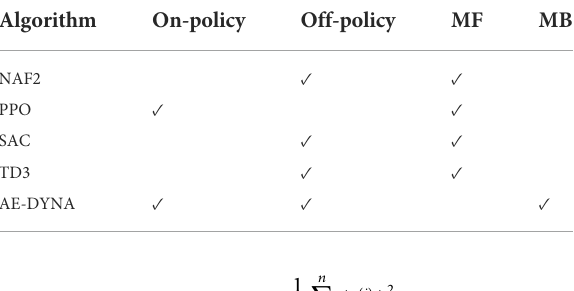
TABLE 1 The RL algorithms attempted in this work along with their typeofpoliciesandwhethertheytrainaworldmodel:Model-Free (MF) or Model-Based (MB).